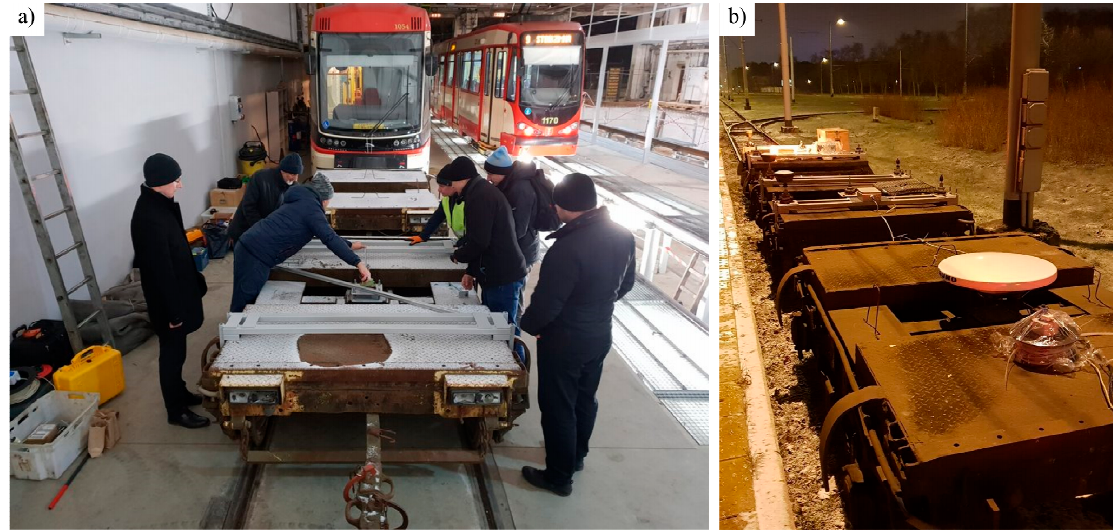
Figure 3. Preparations ( a ) and the measuring instruments during the measurement at night on 28